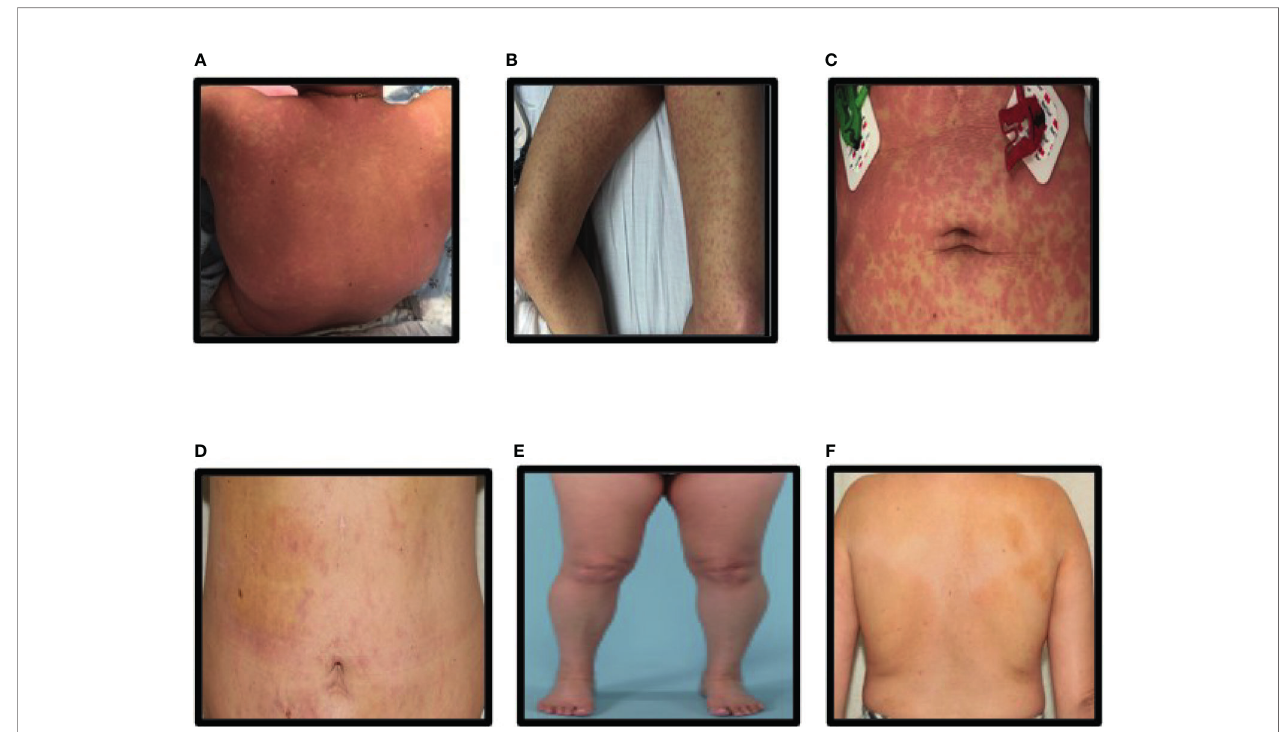
FIGURE 1 | (A – C) Rash on the back, legs, and abdomen at presentation, (D – F) Rash on the back, legs, and abdomen after steroid